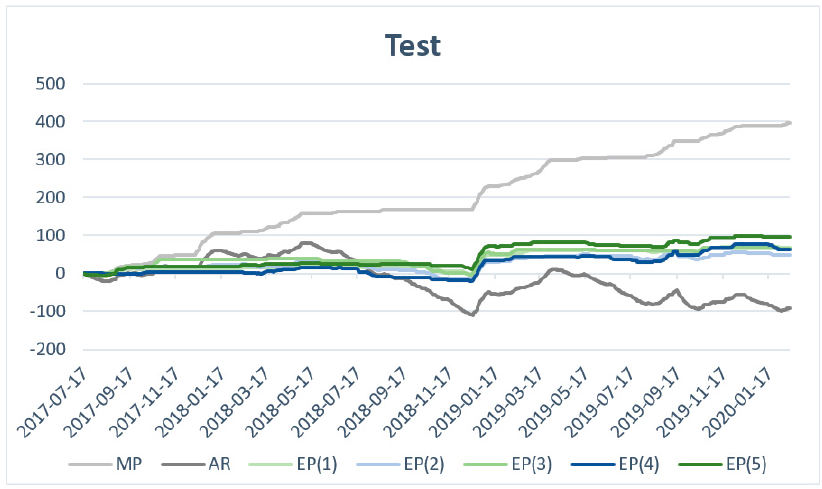
Figure 8. Development of the MP and AR indicators and the EP indicator in the test set for the top five SANNs in the training set (in USD/b).